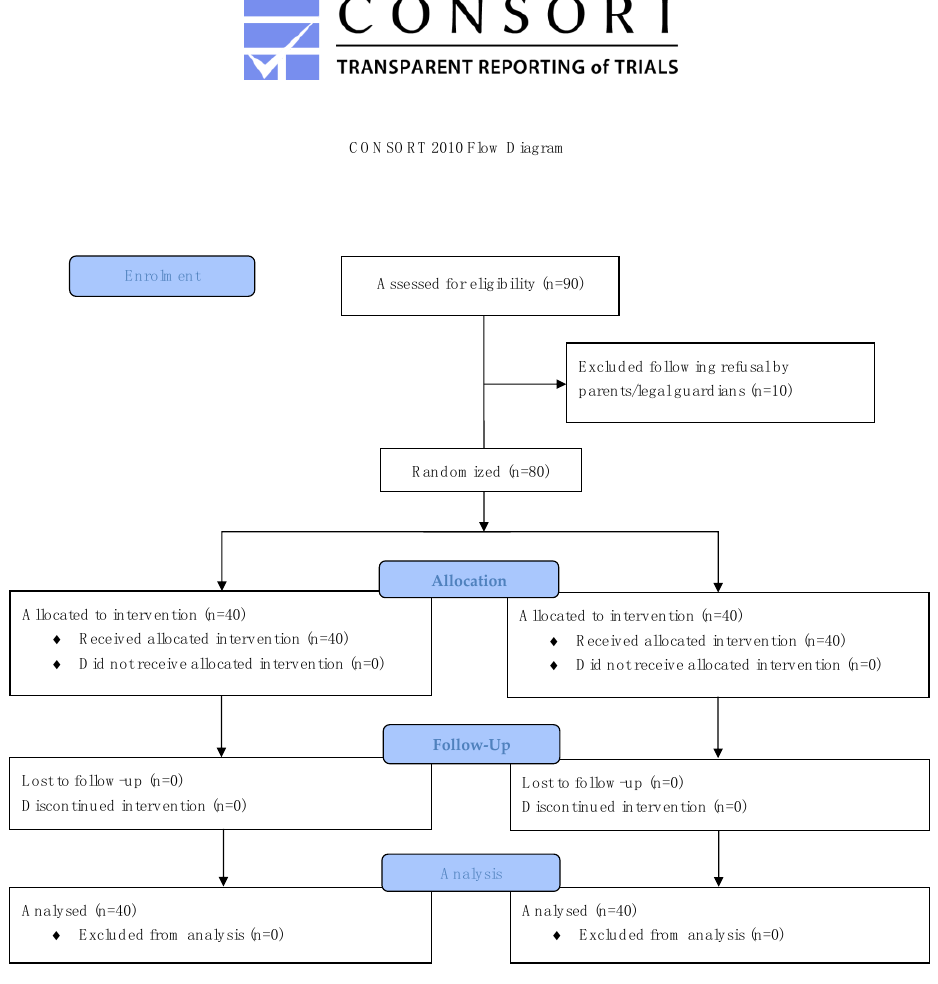
Figure 1. Flow chart of the randomized controlled trial according to